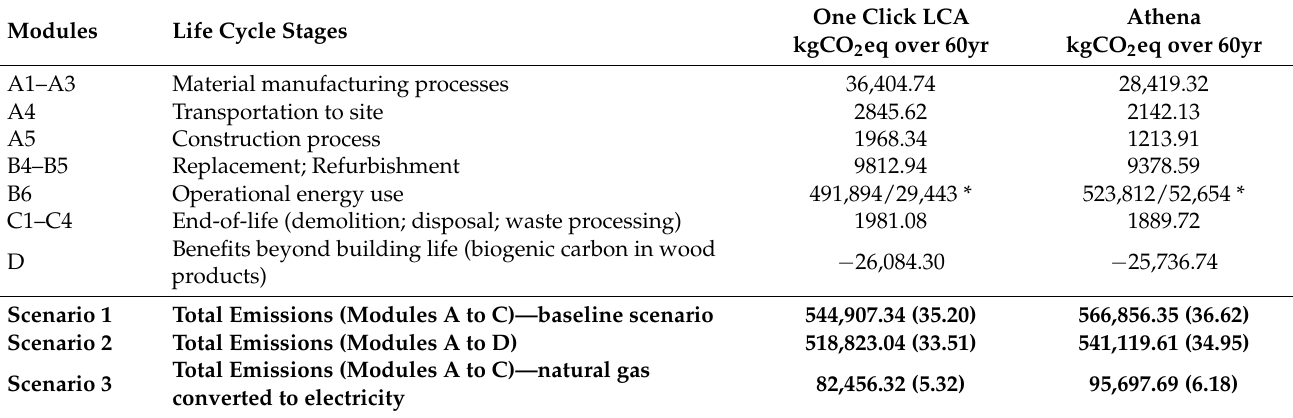
Table 8. LCA results for the single-detached house: Global warming potential (without contribution of